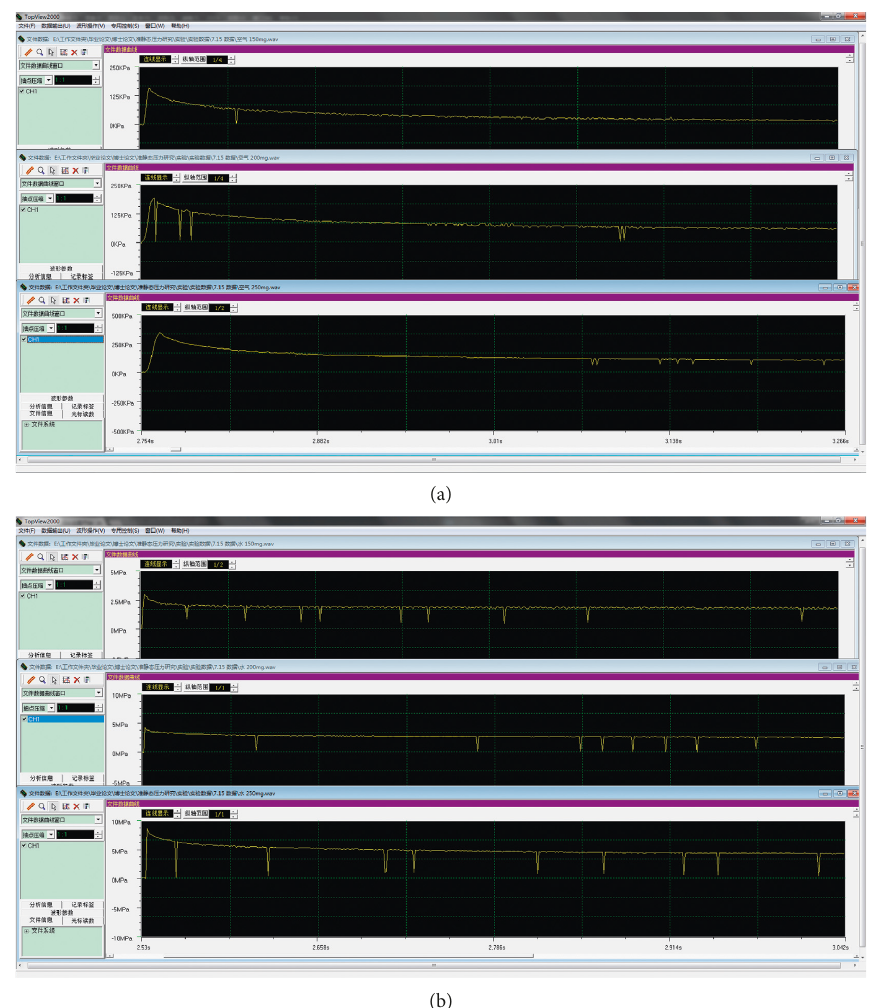
Figure 7: Explosion pressure and quasi-static pressure original curves from (a) noncoupled air charging and (b) noncoupled water charging.